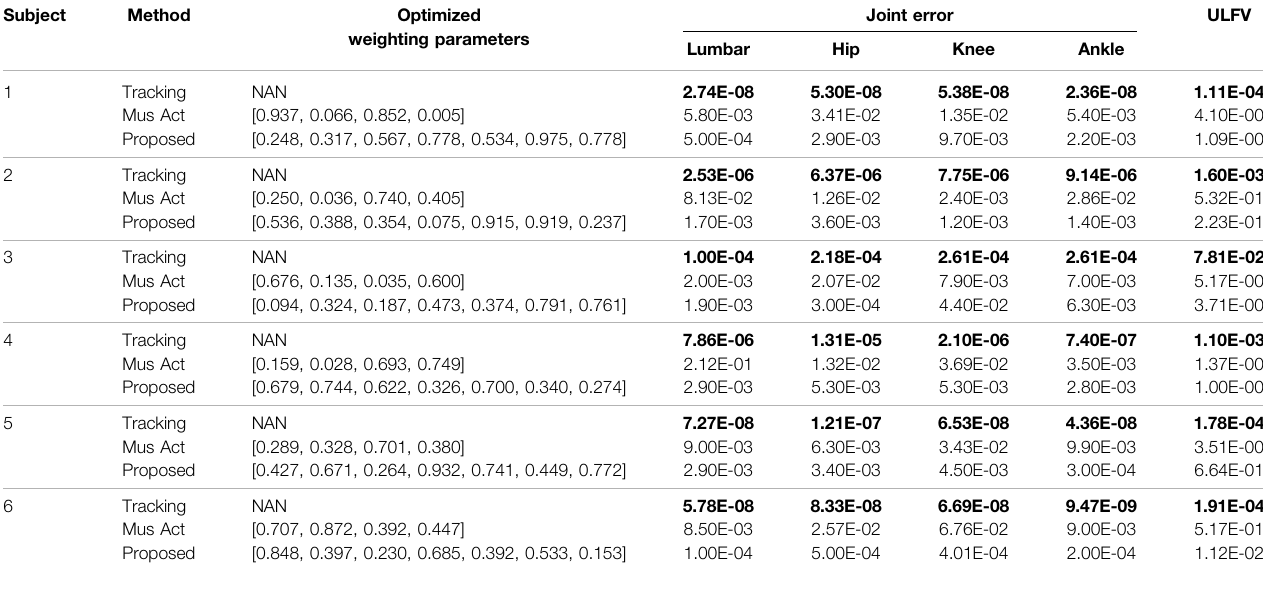
The best simulation results among different methods.